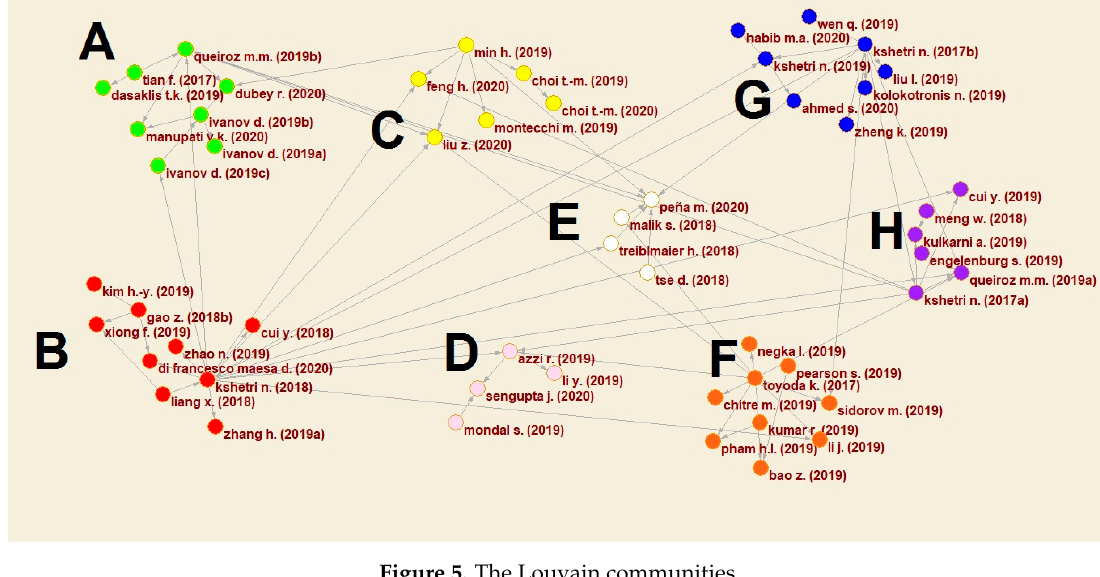
Figure 5. The Louvain communities.